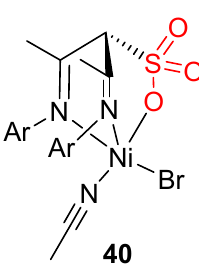
Figure 34. Neutral tridentate α -sulfonato- β -diimine nickel catalyst 40 .